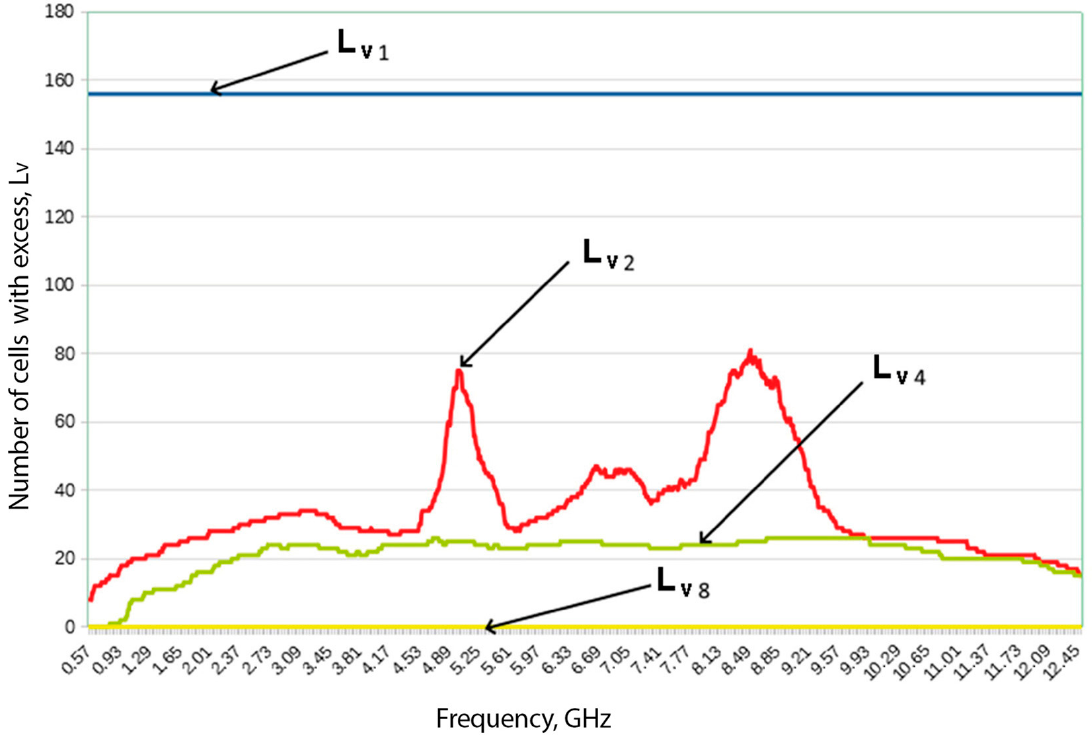
Figure 10. Number of cells with excess L v at different EMW frequencies depending on the value L v .